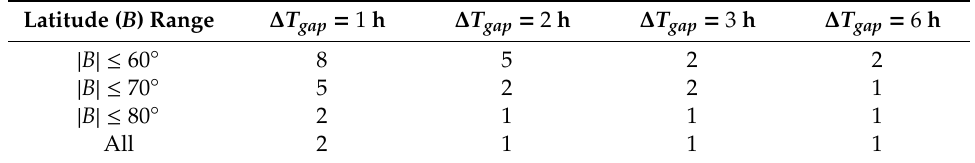
Table 1. Minumum number of the land-based GMSs required to guarantee an observation gap not exceeding Δ(cid:1846) (cid:3034)(cid:3028)(cid:3043) . The data of GRACE FO-1 on 14 August 2018, were used for the calculation. Latitude ( B ) Range